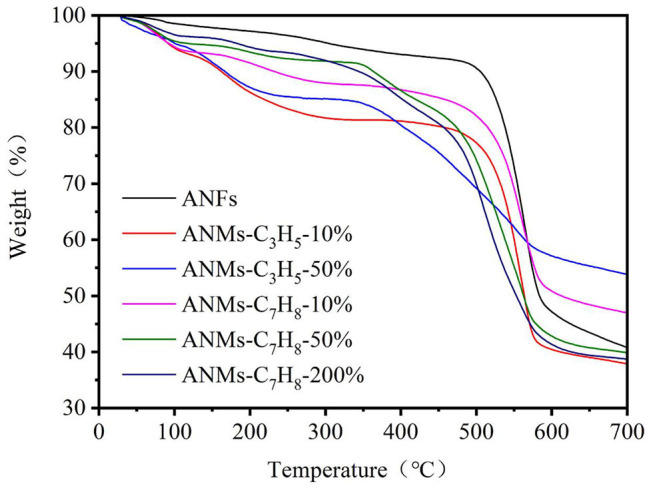
TGA curves of ANFs, ANMs-C3H5-X, and ANMs-C7H8-X.